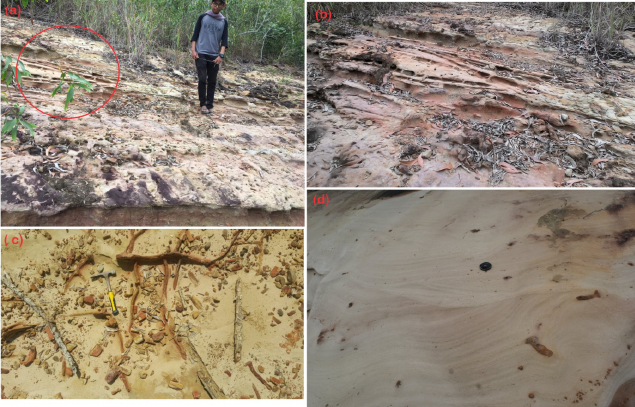
Figure 4: (a) (c) Swaley Cross bed outcrop. cross bed. Thalassinoides sp. exposed on sandstone bed. swaley cross lamination with a few sets of